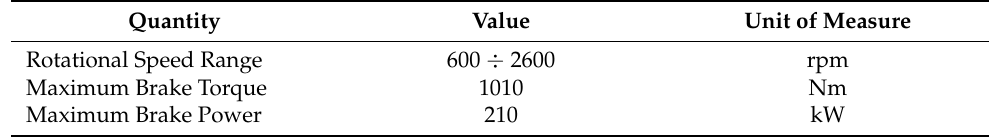
Table 2. Engine performance